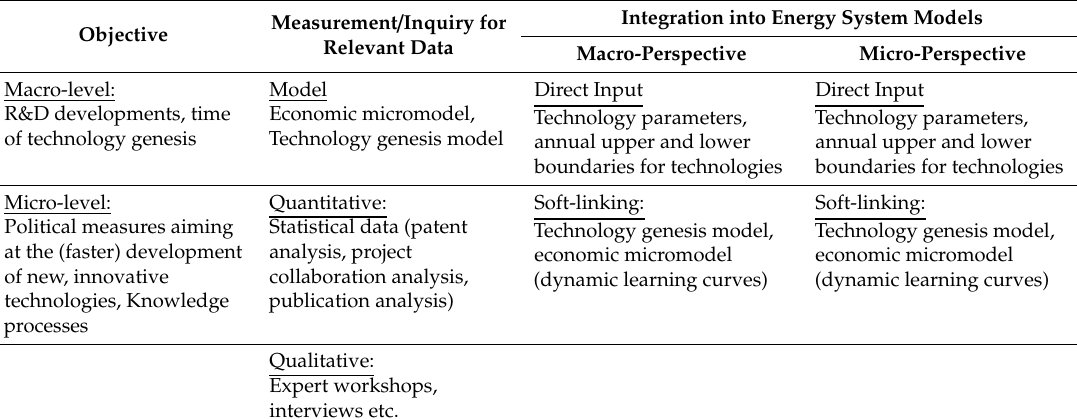
Table 4. Overview of objectives, methods of empirical data inquiry and possibilities to integrate technology genesis into energy system models